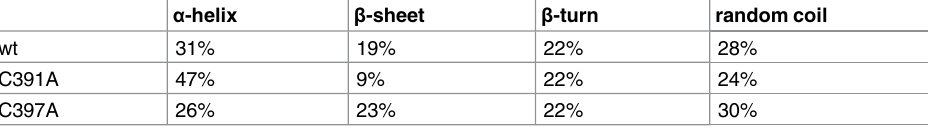
Table 2. Distribution of secondary structure motifs in wt and mutated Pck based on circular dichro- ism measurements.